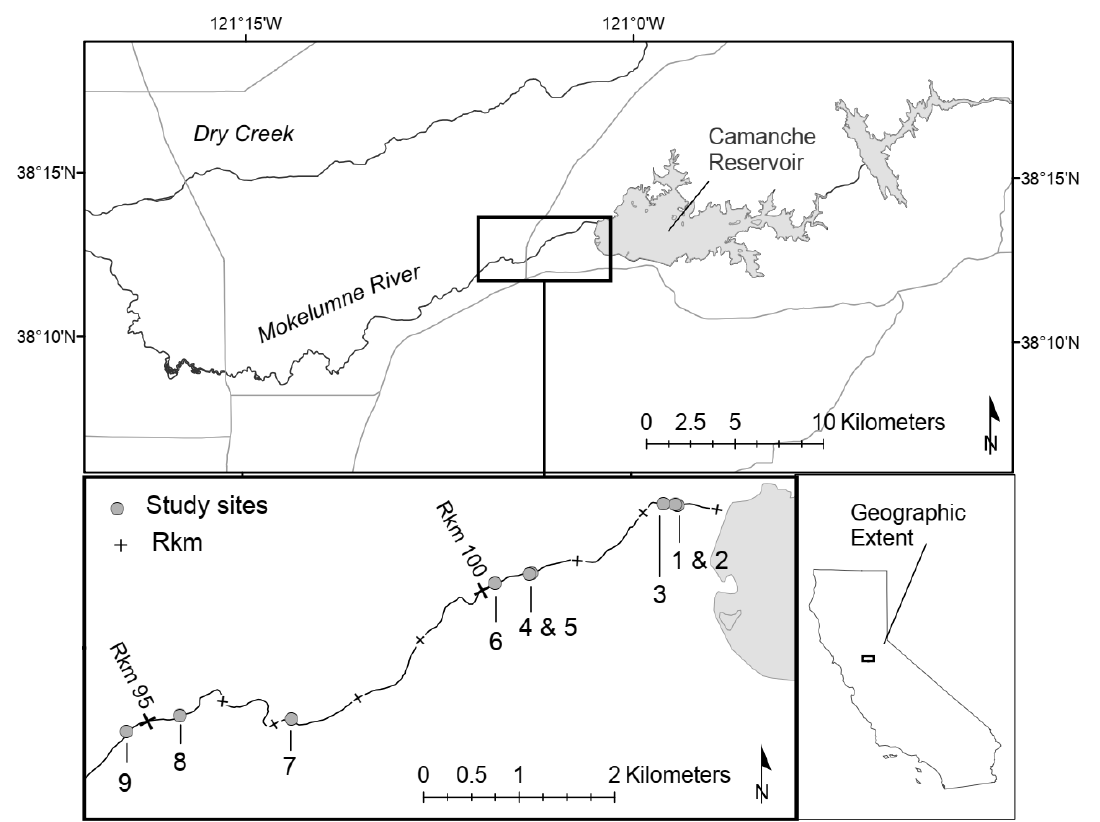
Figure 1. Study sites (1–9) on the lower Mokelumne River, California. Each site included a pair of independent spawning areas with similar geomorphic units; one containing in-channel structure and one without.